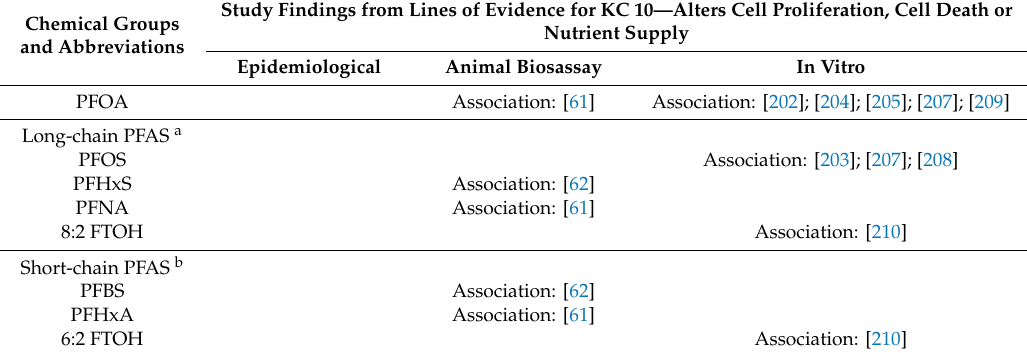
Table 8. Chemical specific study findings for key characteristic 10—modulates receptor-mediated e ff ects. Chemical Groups and